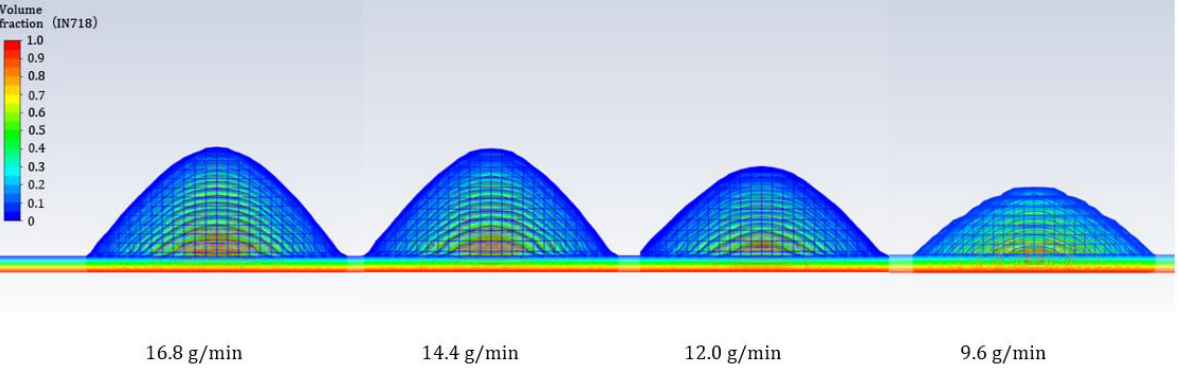
Figure 4. Simulation results of powder deposition channel shape under different powder feeding rates